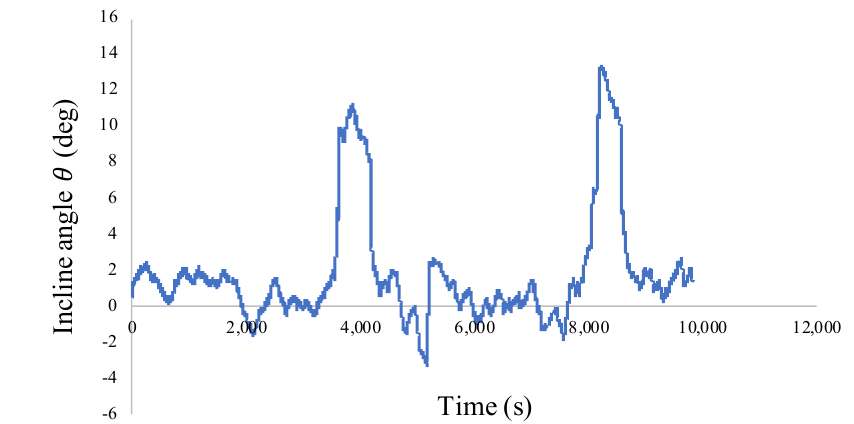
Figure 14. Incline angle detected from gyroscope.